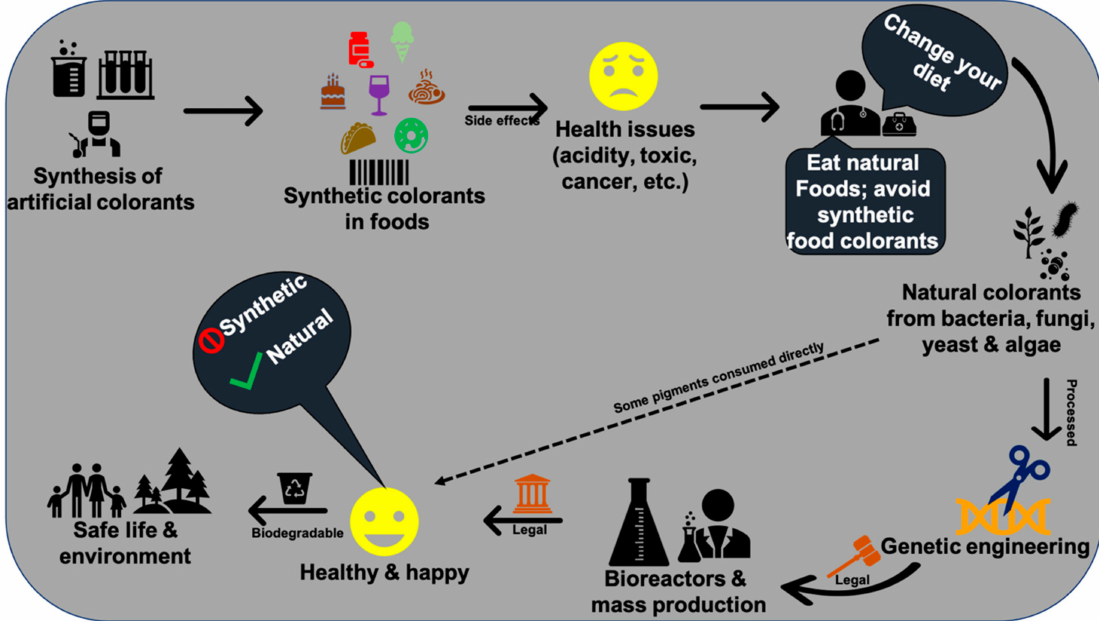
Figure 7. An illustration explaining the requirement of natural colorants over synthetic